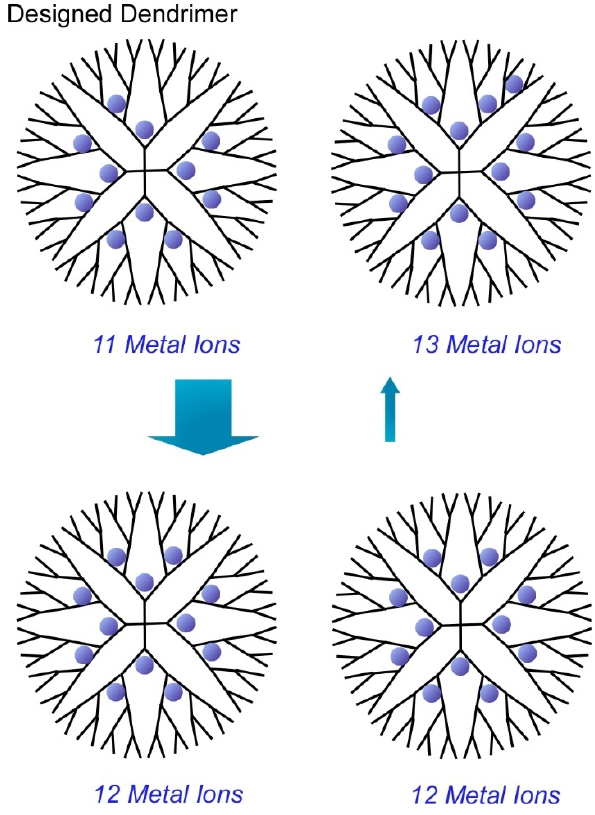
Figure 12. Structurally defined dendrimer cores to give metal cluster with precisely controlled number (12 atoms).